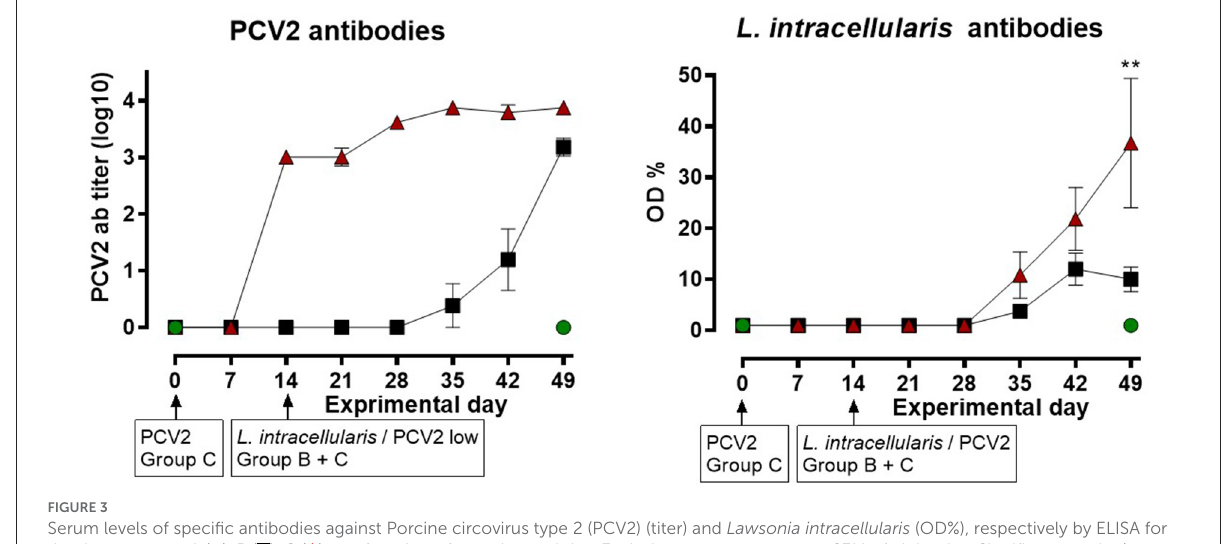
FIGURE3 Serum levels of specific antibodies against Porcine circovirus type 2 (PCV2) (titer) and Lawsonia intracellularis (OD%), respectively by ELISA for the three groups: A ( ), B ( ), C ( ) as a function of experimental day. Each dot represents mean ± SEM of eight pigs. Significant results ( p < 0.01) are marked by **.